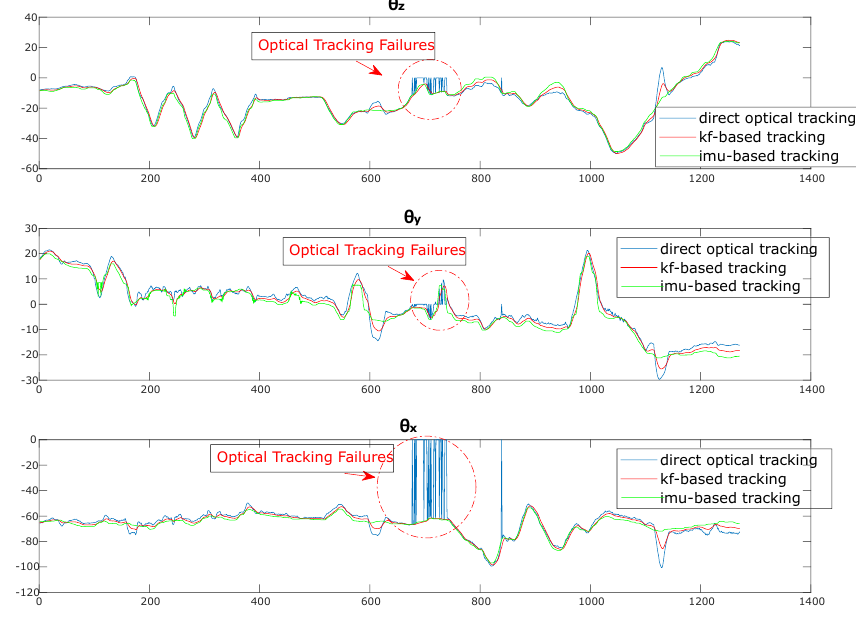
Figure 6. Time series of the Euler angles obtained the optical tracking, the inertial tracking, and the Kalman Filter-based heterogeneous tracking. For a better result display, only the first 1250 frames of the dynamic test are shown. Optical tracking failures are red circled. The trend of the Euler angles are at times rather different owing to the optical tracking ambiguities caused by variable lighting conditions and degraded tracking camera